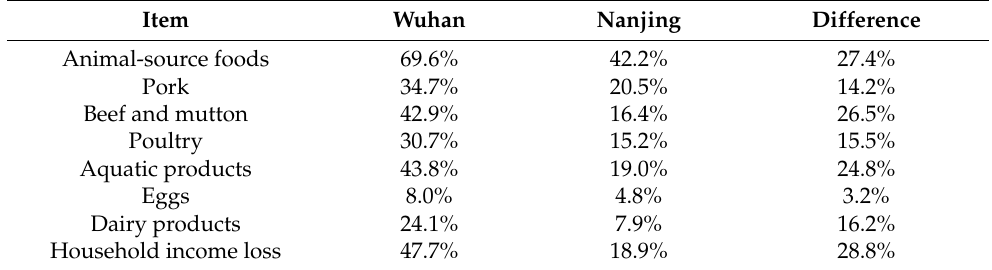
Table 3. Proportion of households experiencing income losses and challenges in animal food consumption.